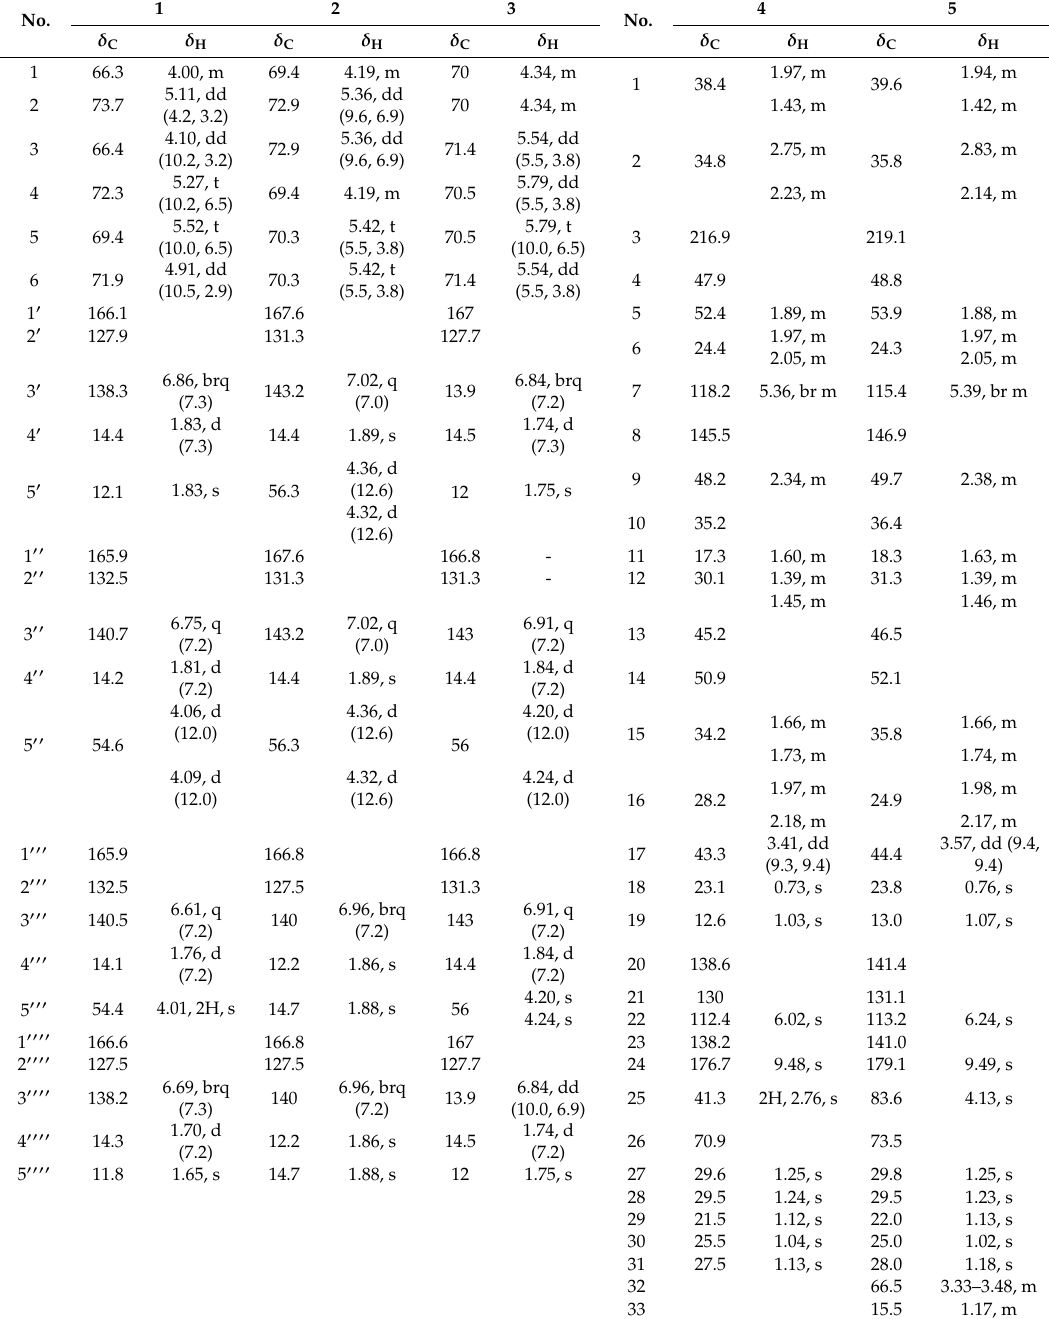
Table 1. 1 H- and 13 C-NMR spectra data of 1–5